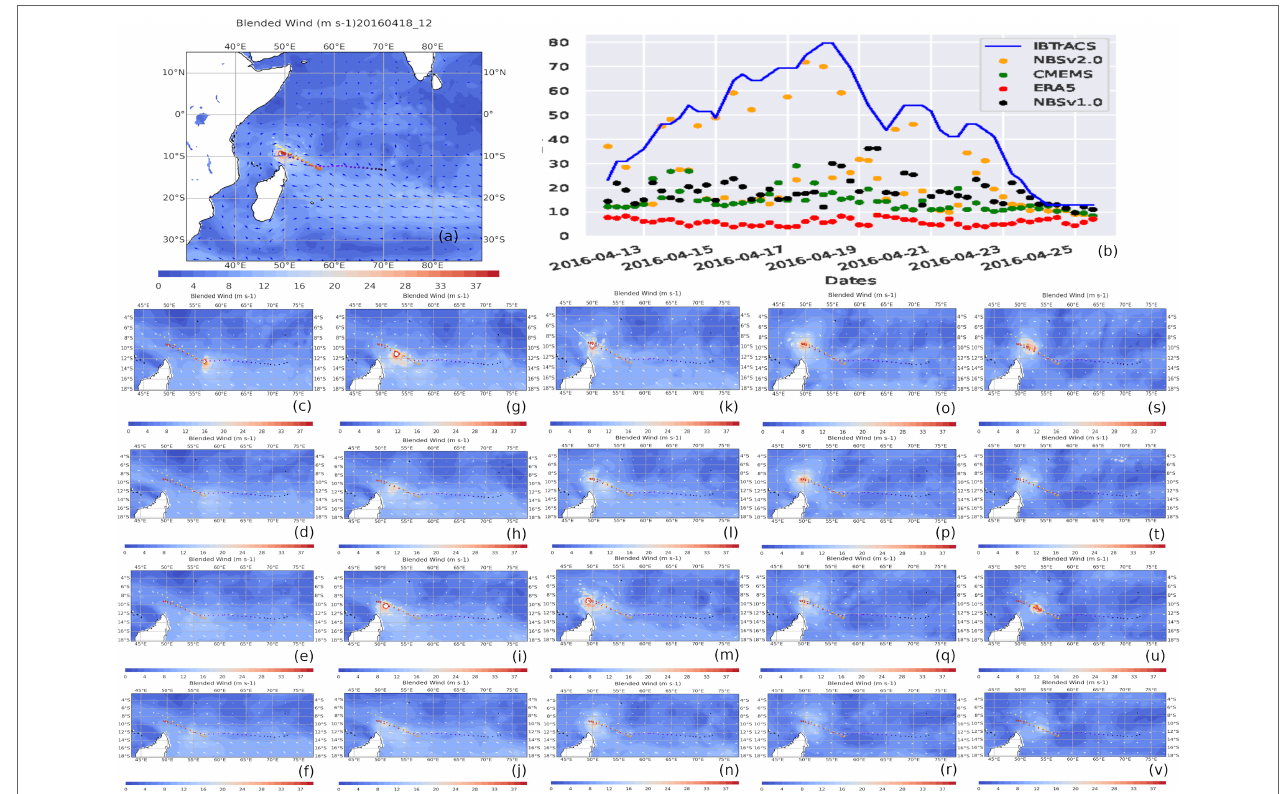
FIGURE 7 | (A) Tropical cyclone Fantala’s maximum wind speed with best track from the IBTrACS data set. (B) Time series of maximum wind along the track of the Tropical Cyclone Fantala. (C–V) Five days of wind data in and around the peak of the storm (on April 18, 2016), for different days (along the rows) and 4 snapshots for each day (along the